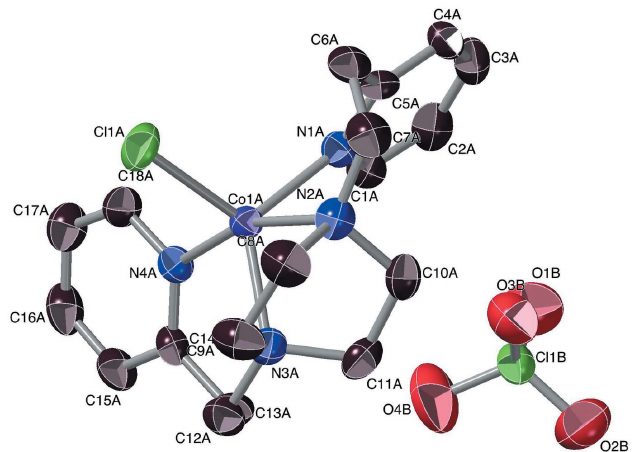
Figure 4 Structural representation of [Co(Ppz)Cl]ClO 4 (major component). The perchlorate is disordered by a rocking motion along the O2 B –Cl1 B –O4 B direction, which may be related to weak C—H (cid:6)(cid:6)(cid:6) O hydrogen-bonding interactions. Ellipsoids are drawn at the 50% level, and for clarity of presentation, H atoms are omitted.